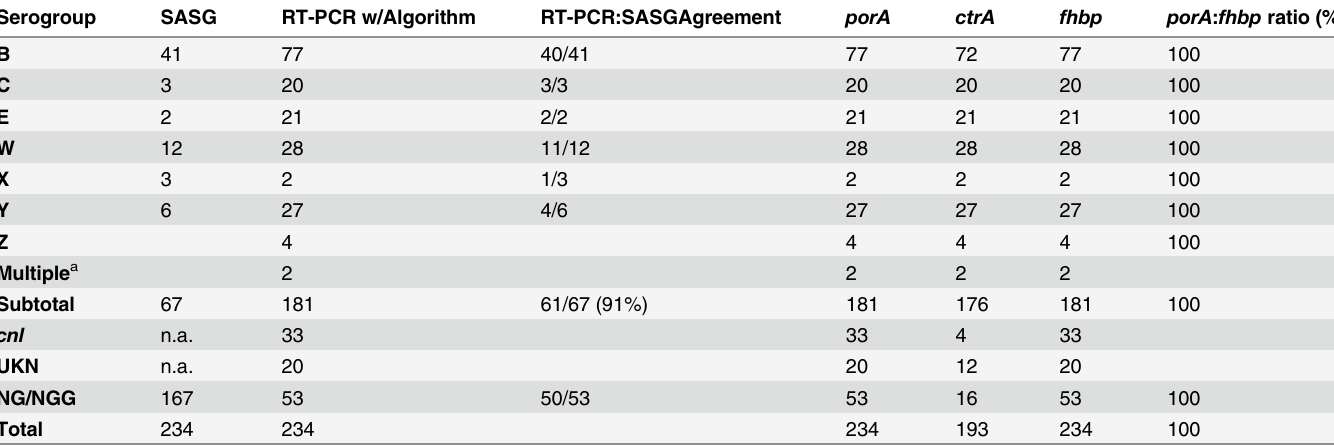
n.a. = not applicable; NG = nongroupable by SASG assay; NGG = nongenogroupable by rt-PCR assays; UKN = unknown (no result by genogrouping rt- PCR assays and cnl PCR negative or not done). a Positive result with two rt-PCR genogrouping assays (Ct <